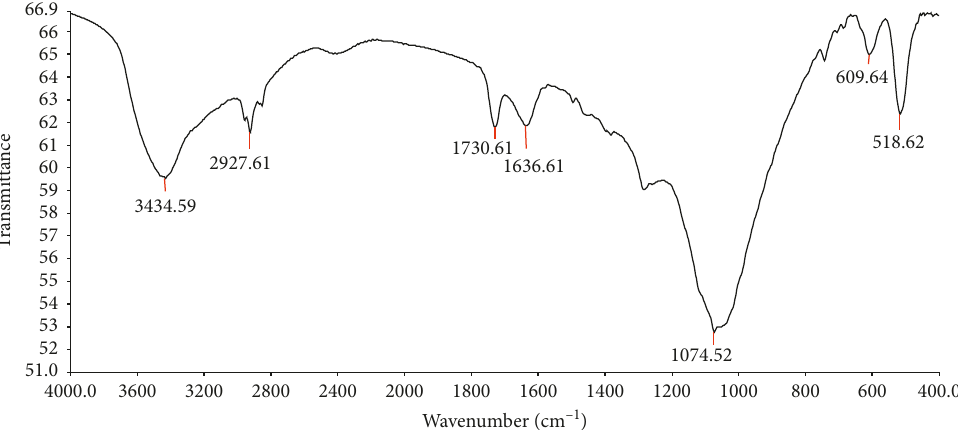
Figure 9: FTIR spectrum of PANI/PVC-PEDOT: PSS-ZrP